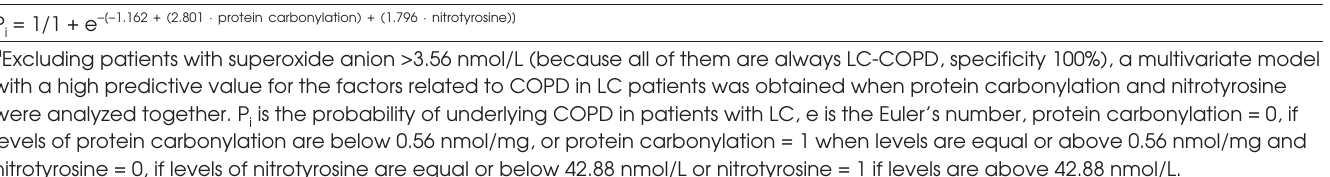
a ROC curve area in blood for LC-COPD with respect to LC patients. b Sensitivity, specificity, PPV and NPV, all expressed as percentage, with 95% CI, were calculated in all patients with LC-COPD (N = 59) for the best cutoff points of the study variables with respect to LC patients without COPD (N = 21). table 4B. Equation of the multivariate model with a high predictive value for the factors related to COPD in LC patients. a P = 1/1 + e –[–1.162 + (2.801 ⋅ protein carbonylation) + (1.796 ⋅ nitrotyrosine)] i a Excluding patients with superoxide anion >3.56 nmol/L (because all of them are always LC-COPD, specificity 100%), a multivariate model with a high predictive value for the factors related to COPD in LC patients was obtained when protein carbonylation and nitrotyrosine were analyzed together. P is the probability of underlying COPD in patients with LC, e is the Euler’s number, protein carbonylation = 0, if i levels of protein carbonylation are below 0.56 nmol/mg, or protein carbonylation = 1 when levels are equal or above 0.56 nmol/mg and nitrotyrosine = 0, if levels of nitrotyrosine are equal or below 42.88 nmol/L or nitrotyrosine = 1 if levels are above 42.88